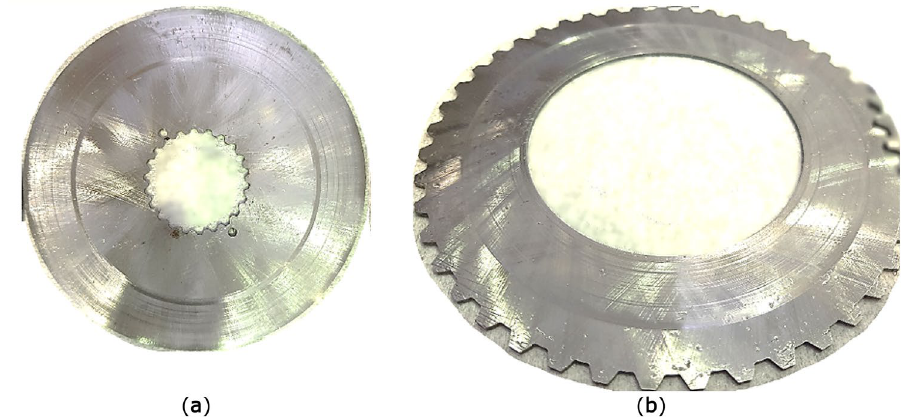
Figure 17. Presentation of wear: ( a ) on friction disc; ( b ) on separator disc.